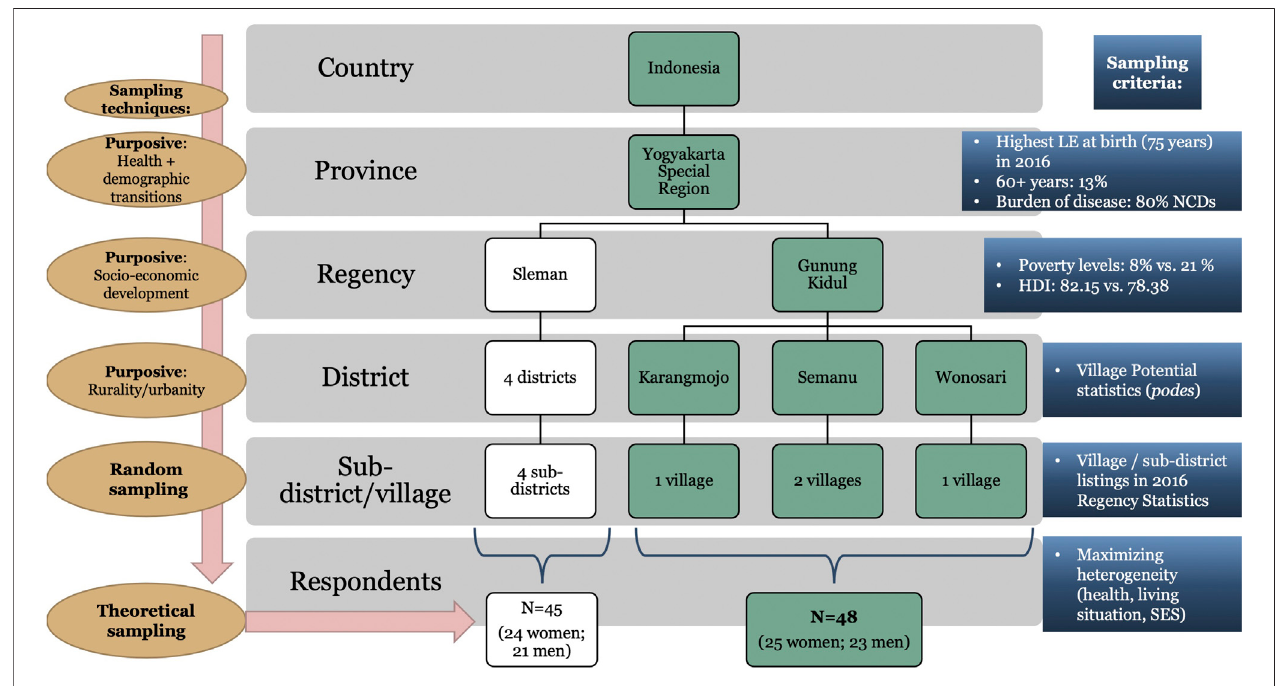
FIGURE 1 | Overview of sampling strategy (Schröders,